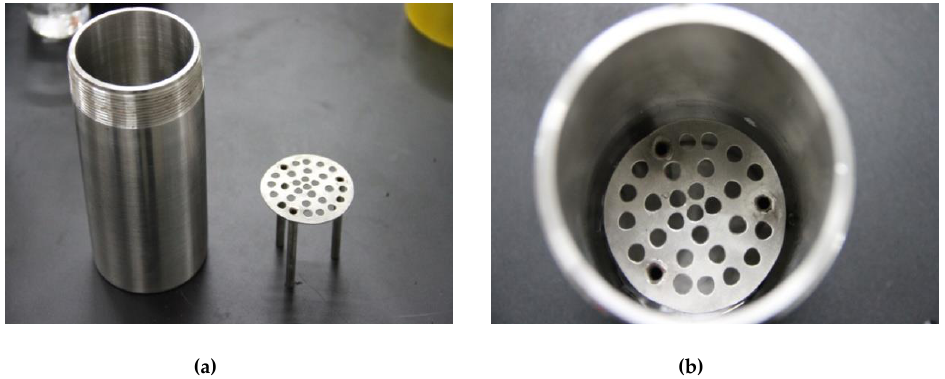
Figure 1. Details of the water-adding device. (a) The picture of a bracket and cylindrical vessel; (b) the bracket was placed into the cylindrical vessel for supporting the cores when adding water vapor.